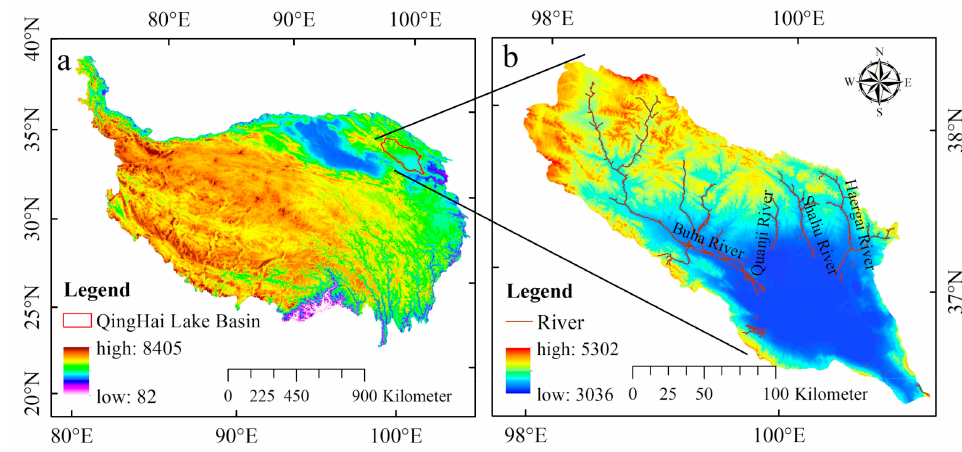
Figure 1. Location of the Qinghai Lake Basin ( b ) on the Qinghai–Tibet Plateau ( a